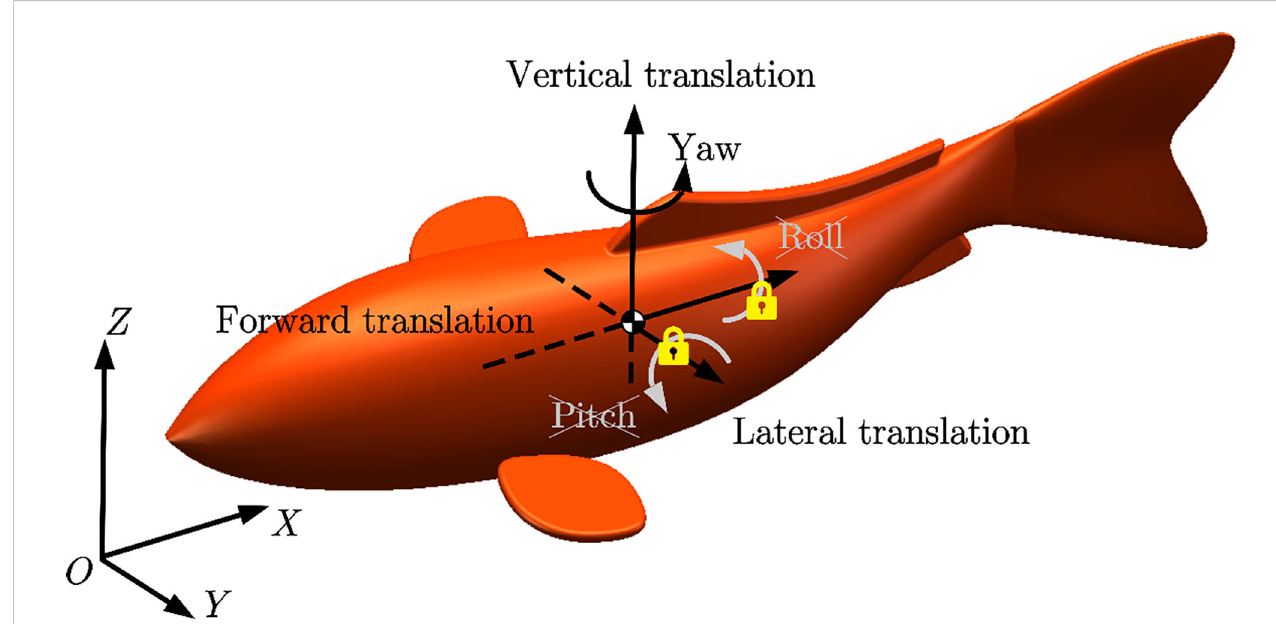
FIGURE 5 Sketch of the world frame OXYZ and the DOFs of the swimmer. DOFs, degree of